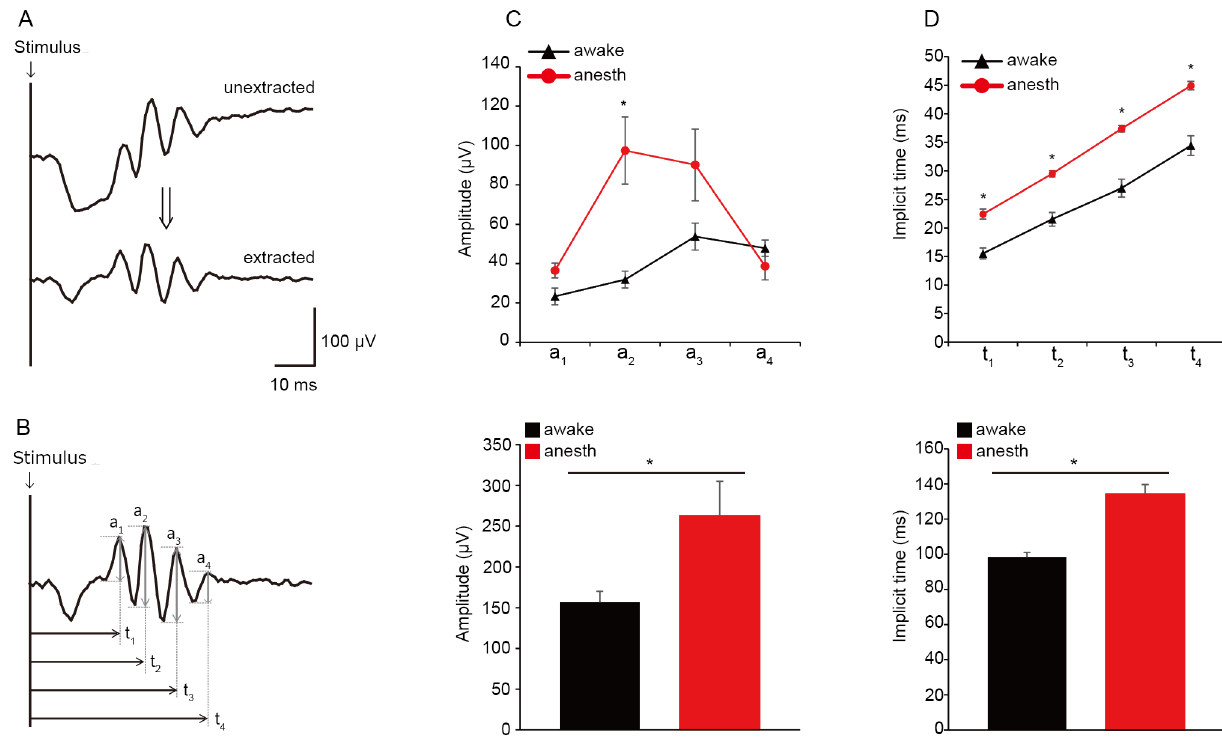
Fig 3. Comparison of OPs extracted from ERGs acquired under awake and anesthetized conditions. Representative ERG traces before and after the extraction of OPs from a scotopic ERG (0 log cd s/m 2 ). Schematic illustration showing the amplitude (a n ) and implicit time (t n ) of each OP wavelet (OP n ). C, D. Amplitudes (C) and implicit times (D) of individual OP wavelets (OP 1 – OP 4 ) recorded in the awake (black) and anesthetized (red) condition from the same mice. E, F. Summed amplitudes (C) and implicit times (D) of all OP wavelets (OP 1 – OP 4 ) from ERGs recorded under awake (black) and anesthetized (red) conditions from the same mice. * P < 0.05. Data from seven mice. The bars indicate mean ± S.E.M. anes: anesthetized.